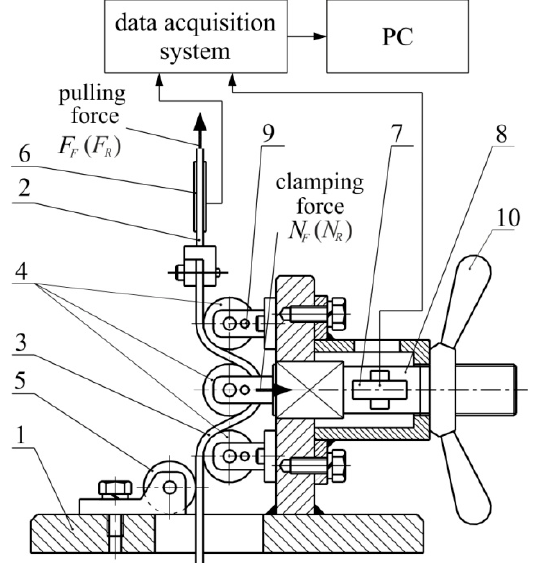
Figure 2. Cross-section of a typical drawbead with circular form: 1—frame, 2—upper tension member, 3—specimen, 4—working rollers, 5—support roller, 6 and 7—load cells, 8—horizontal tension member, 9—pin, 10—wing nut.